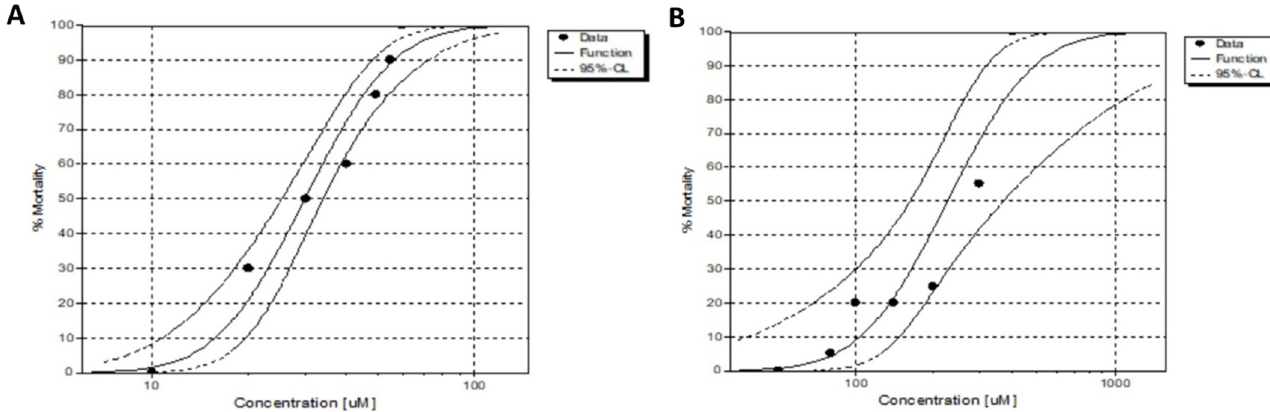
Figure 13. Zebrafish survival in presence of JHOR10 and JHOR11. ( A ) Zebrafish embryo survival when the JHOR10 compound was dissolved in the water. ( B ) Zebrafish embryo survival when the JHOR11 compound was dissolved in the water.